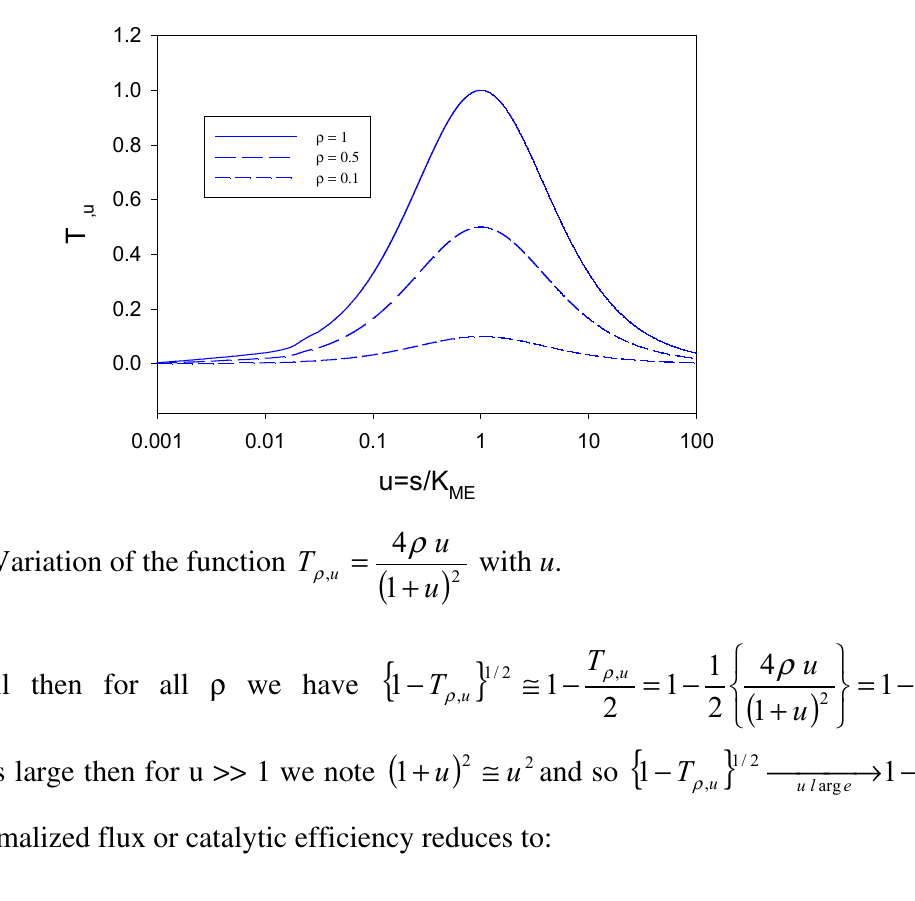
ρ 14 uu += T with u ( ) 2, ρ u